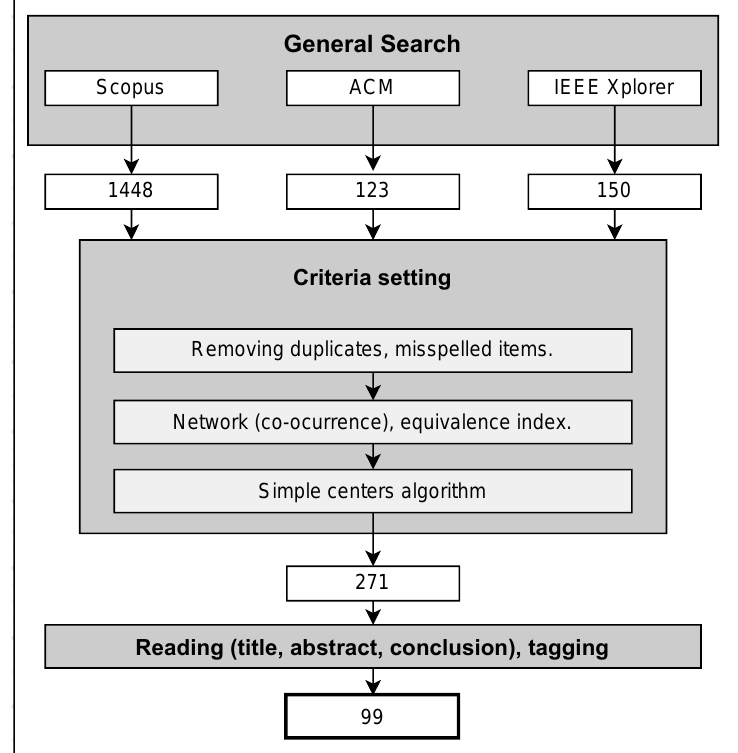
Figure 2. Flowchart.